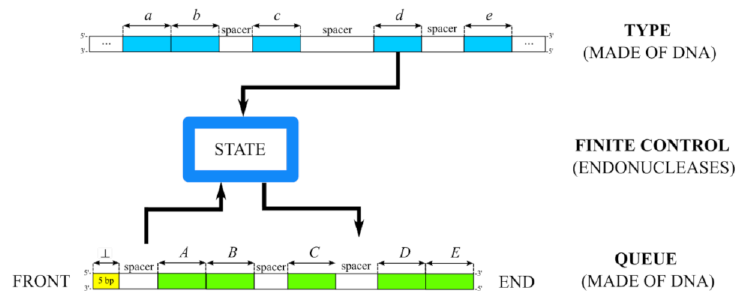
Figure 4. Schematic diagram of a biomolecular queue automaton. Abbreviations: a , b , c , d , e denote the symbols of the biomolecular queue automaton; A , B , C , D , E —the queue symbols of a biomolecular computer; the empty queue symbol denotes the beginning of the biomolecular queue; the spacer denotes the DNA fragment between the input symbols or the queue symbols of the biomolecular queue automaton; 5 (cid:48) , 3 (cid:48) —the DNA chain direction.